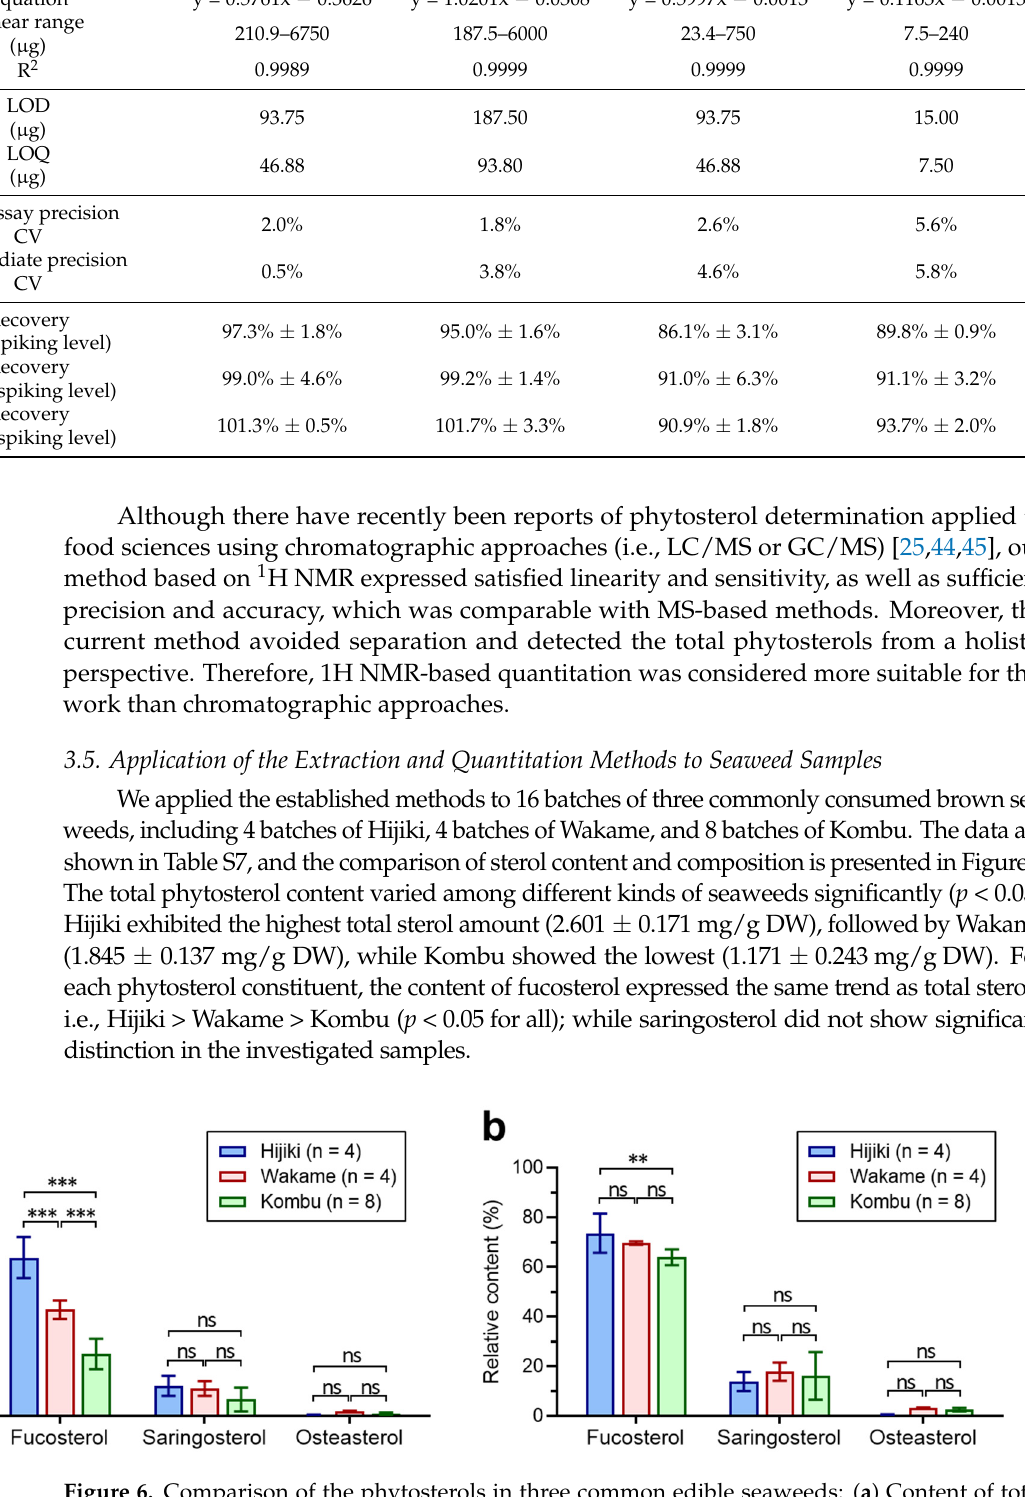
Figure 6. Comparison of the phytosterols in three common edible seaweeds: ( a ) Content of total sterols, fucosterol, saringosterol, and ostreasterol. ( b ) Relative content of phytosterol components. ** p < 0.01, *** p < 0.001, analyzed by one-way ANOVA followed by Tukey’s multiple tests.